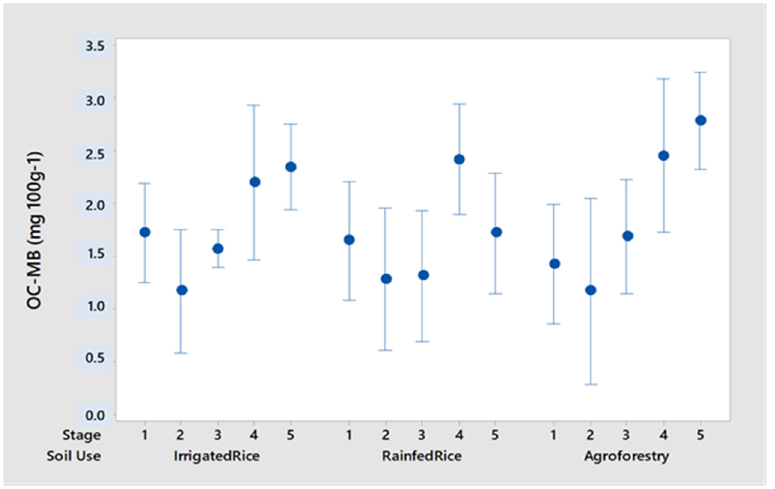
Figure 3. Interaction effect of the soil use and the stage on the organic carbon (OC) of microbial biomass (MB) ( n =6).